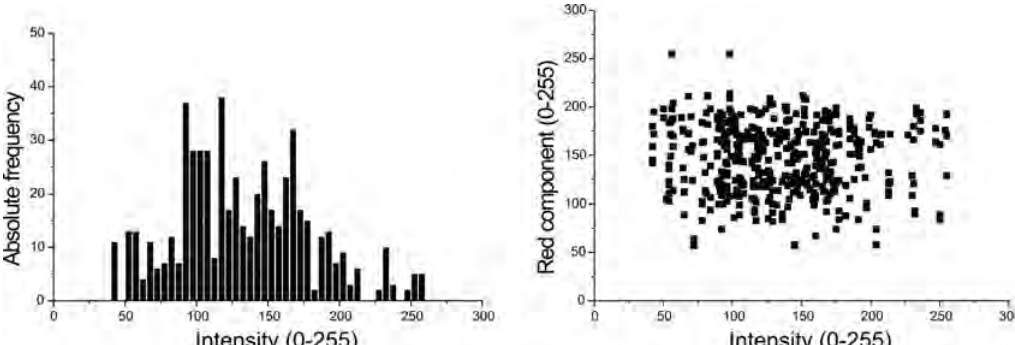
Fig. 5a,b. Statistical distribution of intensity data extracted from the vertical profile of the landslide (a), and plot of intensity vs. red channel